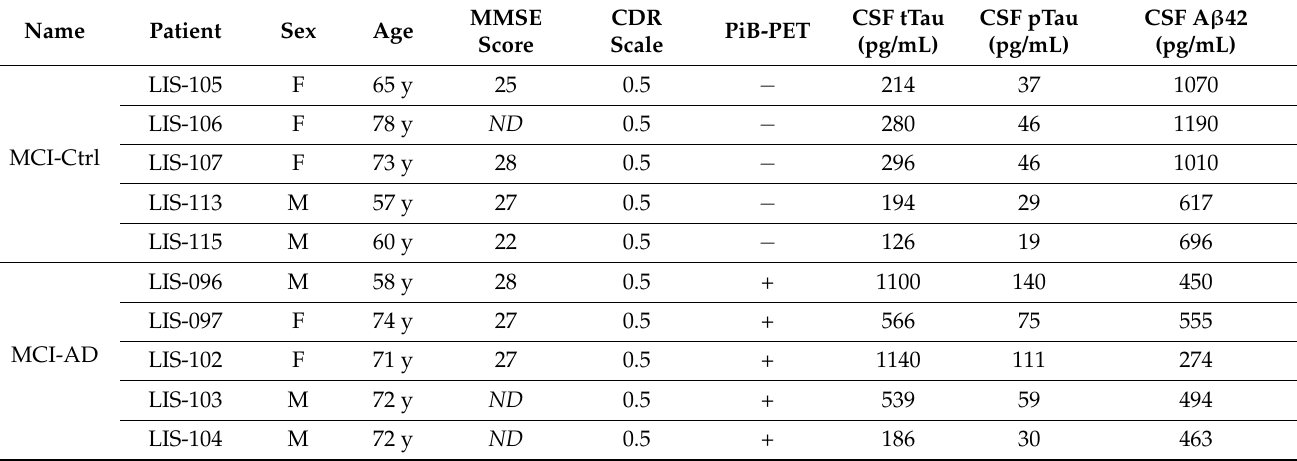
Table 1. Demographic data and clinical assessment of mild cognitive impairment (MCI)